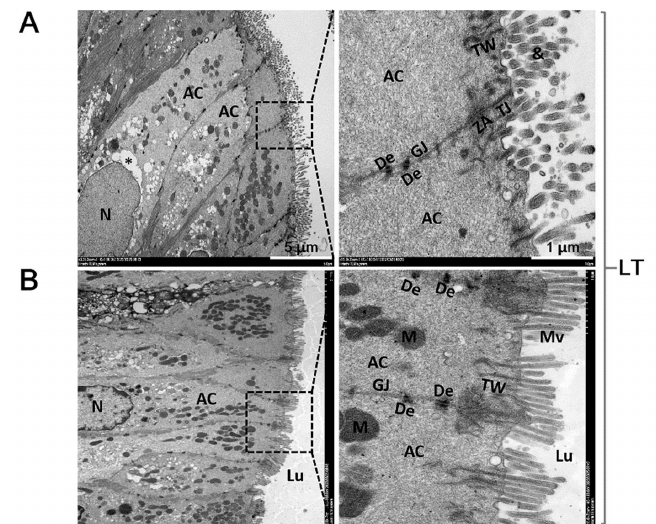
Figure 3. Transmission electron microscopy imaging of colonic mucosal epithelial cells in LT group ( A , B ) and IBA group ( C , D ) of Daurian ground squirrels. Colonic lumen (Lu), absorptive cells (AC), microvilli (Mv), microsomes (&), nucleus (N), mitochondria (M), terminal network (TW), tight junc- tions (TJ), zonula adherens (ZA), desmosomes (De), gap junctions (GJ). LT, late torpor; IBA, inter- bout arousal. 2.4. Ultrastructure of Goblet Cells in Colonic Mucosa The GCs of colonic mucosa were observed by transmission electron microscopy. The results show that the GCs in the LT group were almost open (Figure 4A,B); that is, there